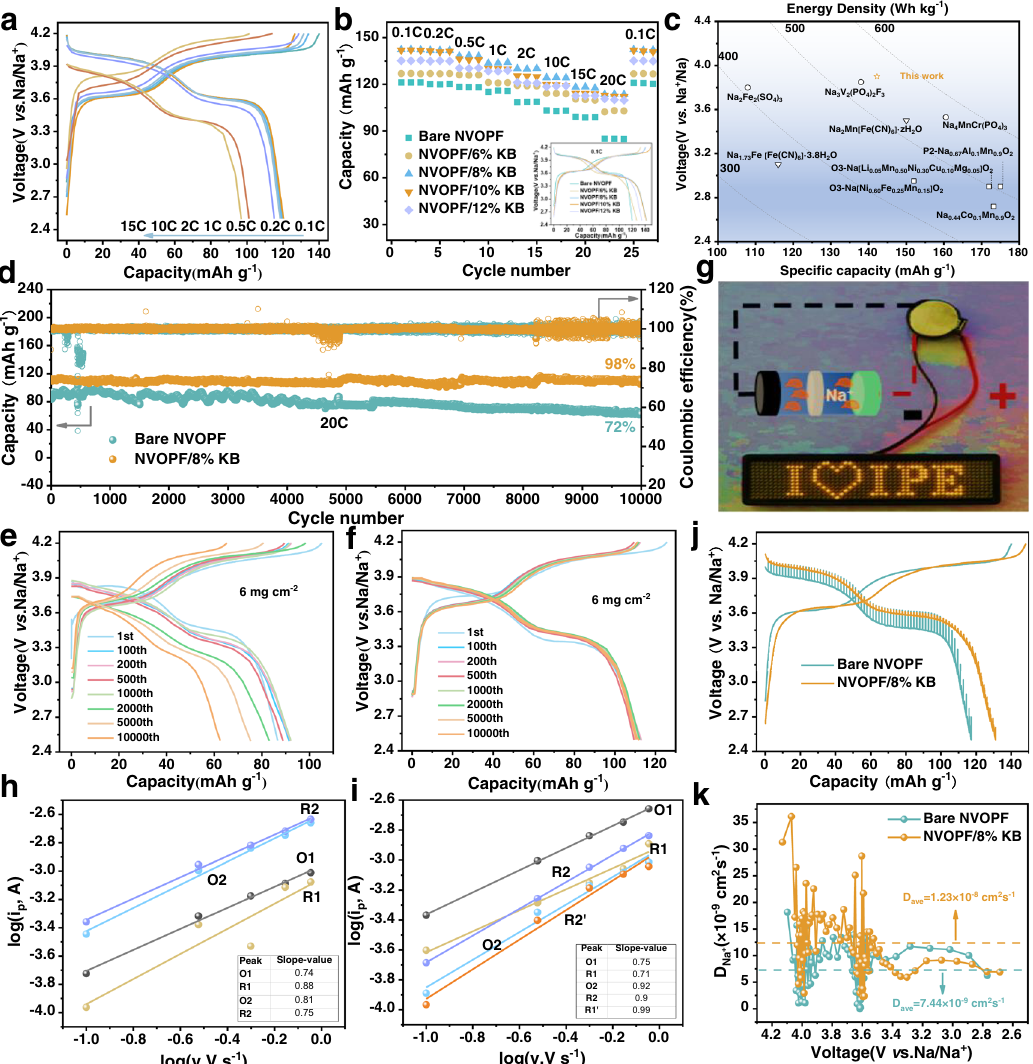
Fig. 3 Electrochemical properties and Na ion diffusion kinetics. a The rate capability of NVOPF electrode at various rates ranging from 0.1C to 15C. b Rate capability of NVOPF with different KB contents at rates ranging from 0.1C to 20C (inset: the typical charge and discharge curves of NVOPF with different KB contents at 0.1C). c Relationships between the working voltage, speci fi c capacity, and energy density in half-cells for NIBs. d The cycling performance of bare NVOPF and NVOPF/8% KB electrode at 20C. e The charge – discharge curves of bare NVOPF cathode at 20C. f The charge – discharge curves of NVOPF/8%KB cathode at 20C. g Photograph of LED lamps lighted by the coin full cell. h Linear fi ttings of log ( i p ) and log (v) for bare NVOPF electrode (inset: the corresponding pseudocapacitive contributions and peak slope values). i Linear fi ttings of log ( i p ) and log (v) disclosing the relationships between peak currents and scan rates from the corresponding CV curves of NVOPF/8%KB electrode. j The GITT curves of bare NVOPF and NVOPF/8%KB. k Corresponding evolution of diffusion coef fi cient of bare NVOPF and NVOPF/8%KB electrodes during the discharging